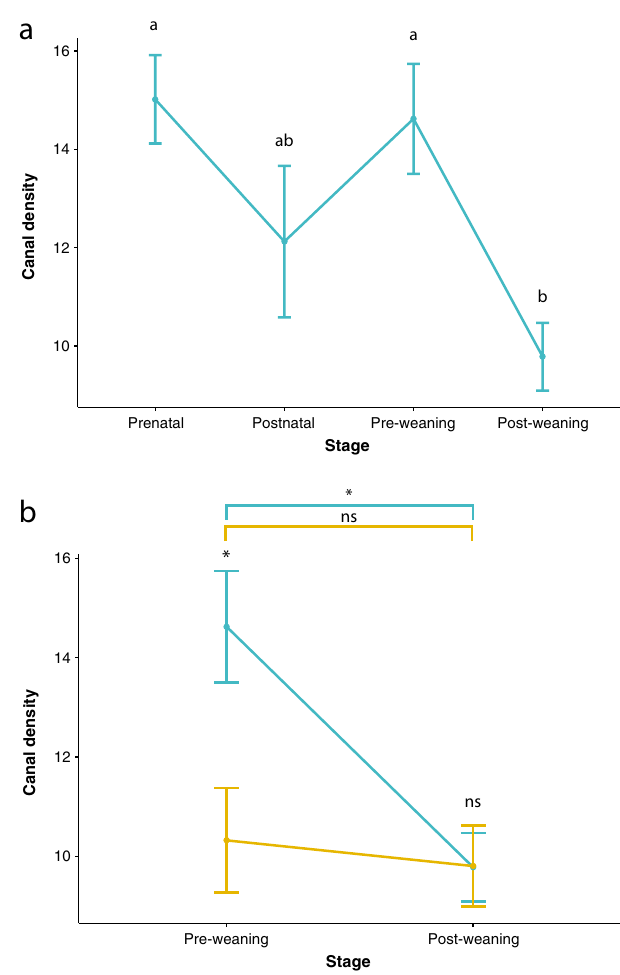
Figure 5. Representation of canal density (mean ± SE in % of the total area contained in a square of 0.370 mm 2 ) ( a ) by ontogenetic periods of hand-raised calves (C2): prenatal (before birth), post-natal (from birth to 30 days), pre-weaning (from 30 days to 13 weeks) and post-weaning (from 13 to 23 weeks) and ( b ) for the pre-weaning (from 30 days to 13 weeks) and post-weaning (from 13 to 23 weeks) periods of both groups of calves (C1 and C2). Specimens staying with their mothers (C1) are represented in orange; hand-raised specimens (C2) are represented in blue. In graph ( a ), different letters above each point indicate significant differences (when groups show different letters) and non-significant differences (when groups share a letter) between groups according to Tukey post-hoc comparisons (p < 0.05). In graph ( b ), ns: no significant